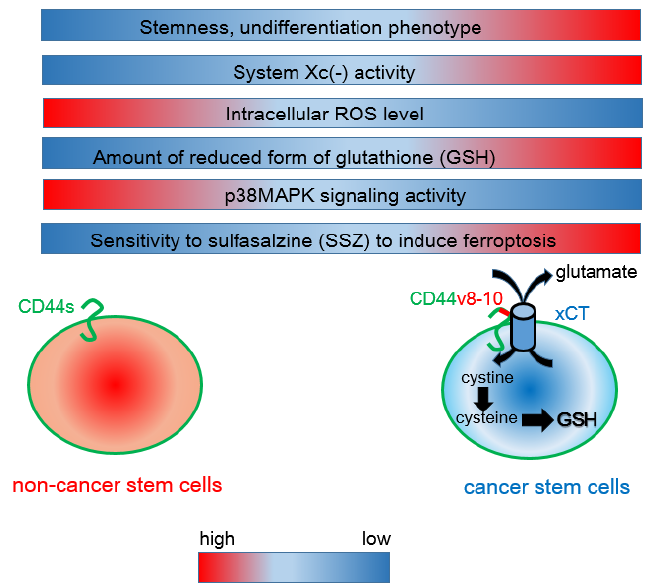
Figure 1. Interaction between CD44 variant 8-10 (CD44v8-10) and the xCT antiporter determines the resistance to oxidative stress. Unlike mesenchymal cancer cells expressing CD44 standard (CD44s), CD44v8-10-positive cancer stem-like cells exhibit robust system Xc(-) activity, resulting in enhanced uptake of cystine. Given that cysteine is a rate-limiting factor for the synthesis of the reduced form of glutathione (GSH), CD44v8-10-expressing cancer cells show a phenotype of increased resistance to redox stress. Sulfasalazine (SSZ) inhibits the xCT transporter and is therefore effective for blocking the CD44v8-10-xCT-GSH axis.